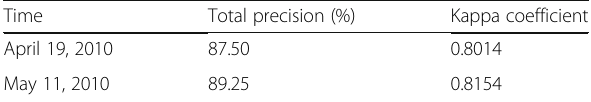
Table 4 Accuracy evaluation of MODIS image Time